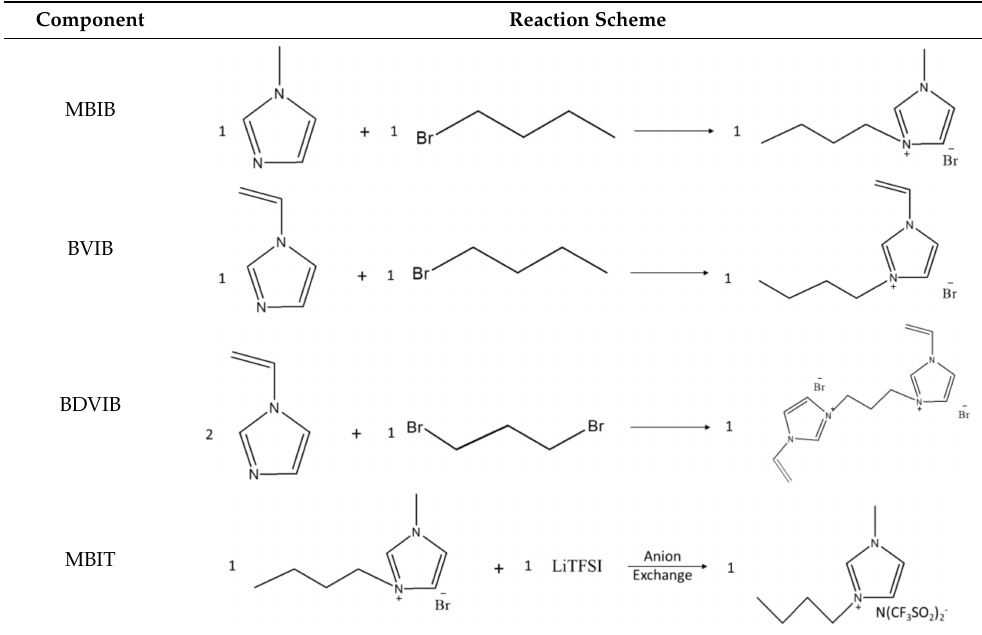
Table 1. Preparation process of the ionic liquid